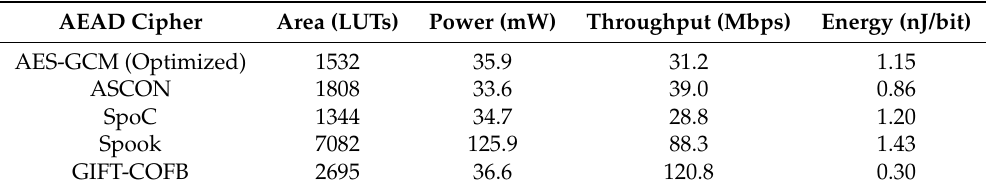
Table 4. The hardware implementation result of AEAD